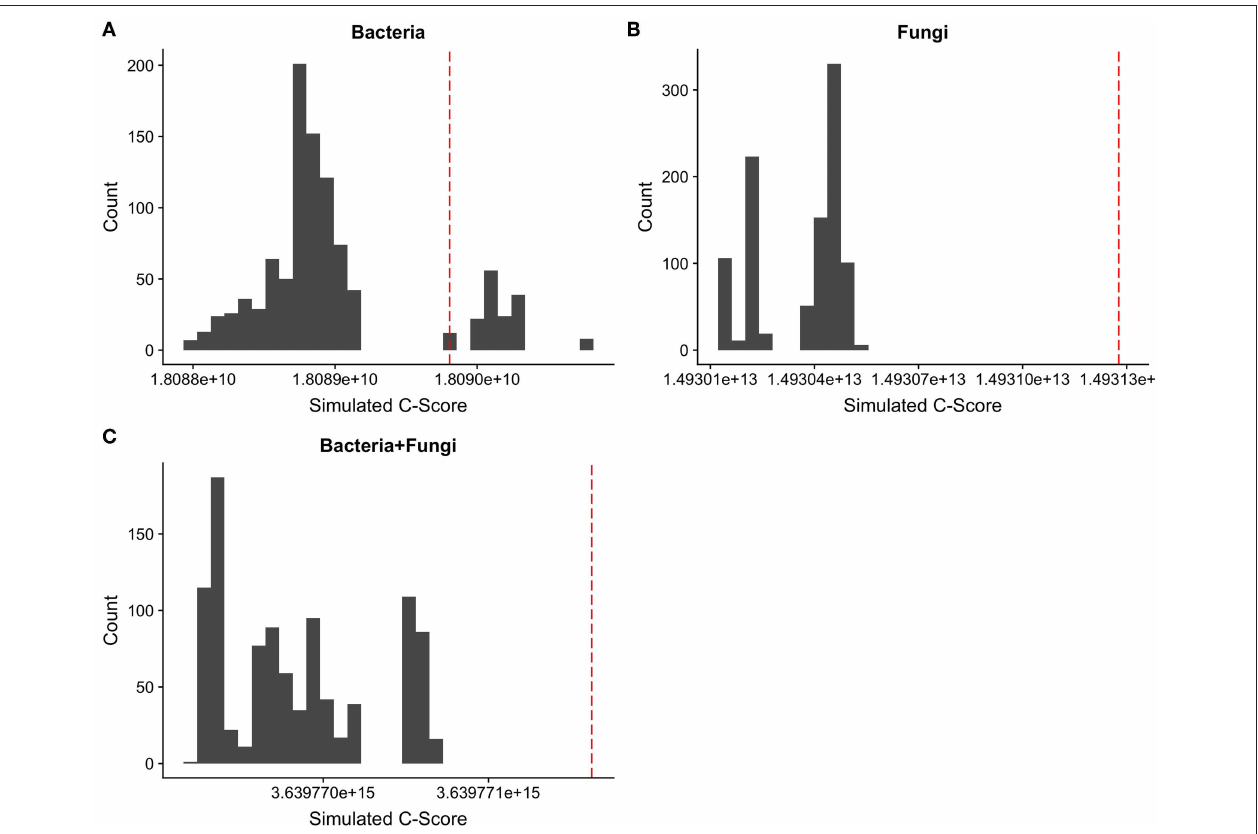
FIGURE 4 | Distribution of c-scores for 1,000 random permutations of (A) bacterial, (B) fungal, and (C) combined OTU datasets. The red line indicates the observed c-score for each OTU community. An overlap of the observed c-score with permutated c-score indicates no difference of c-score from that generated at random, whilst an observed c-score much higher than the permutated data indicates significant segregation effects between OTUs and thus potential